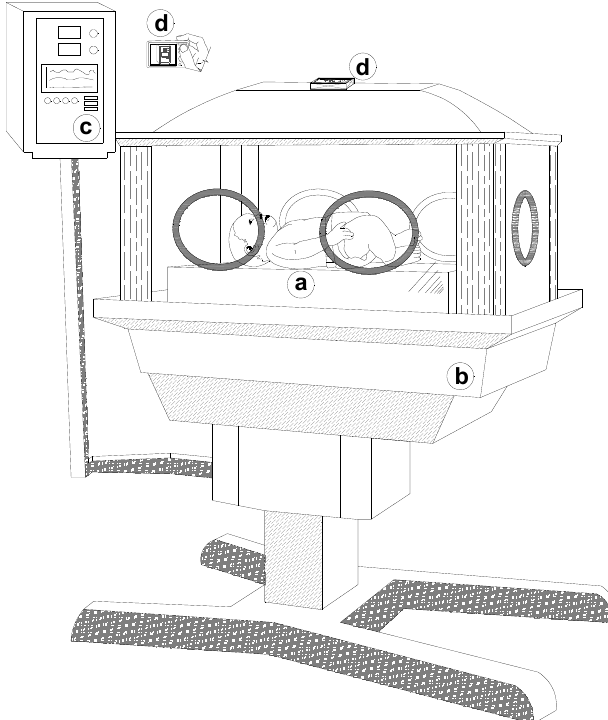
Figure 2. Setup of the experiment: ( a ) neonate, ( b ) Neonatal Intensive Care Unit (NICU Incubator, ( c ) vital signs monitor, and ( d ) cameras.